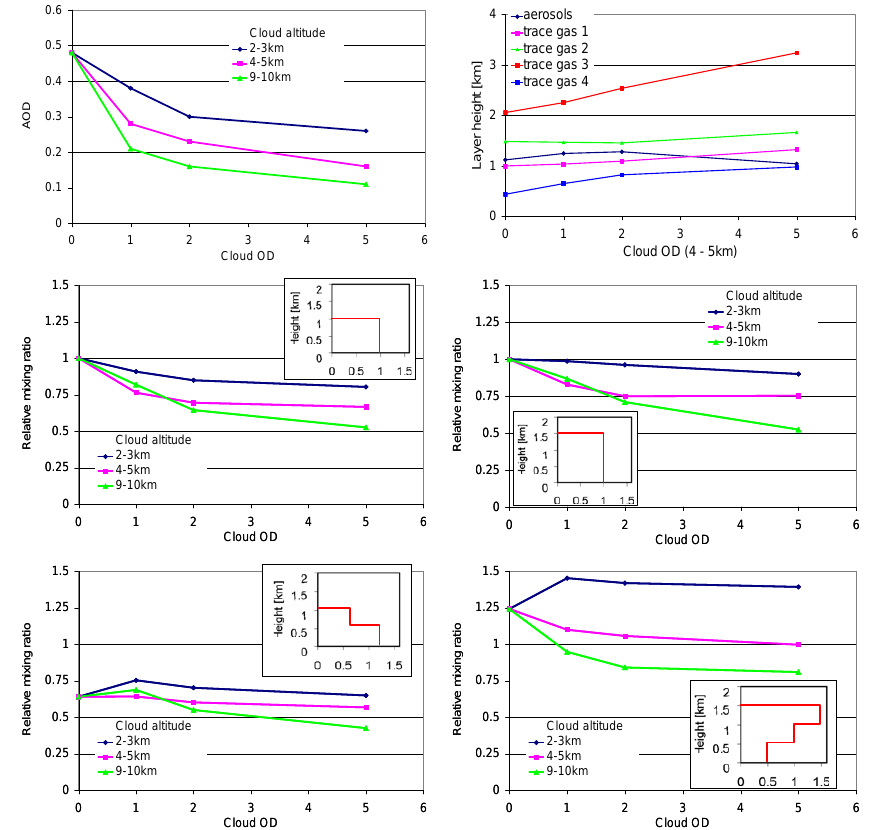
Fig. 12 Results of aerosol inversions (top left) and trace gas inversions (center and bottom) for the simulations shown in Fig. 11 (the forward model assumes clear sky conditions). For the aerosol retrieval and most trace gas retrievals, the diffusing screen effect leads to an underestimation. For trace gases located at relatively high altitude, also an overestimation can occur. Also the retrieved layer heights depend on the cloud properties (top right). (calculations for SZA=45 ◦ , relative azimuth angle=30 ◦ ).